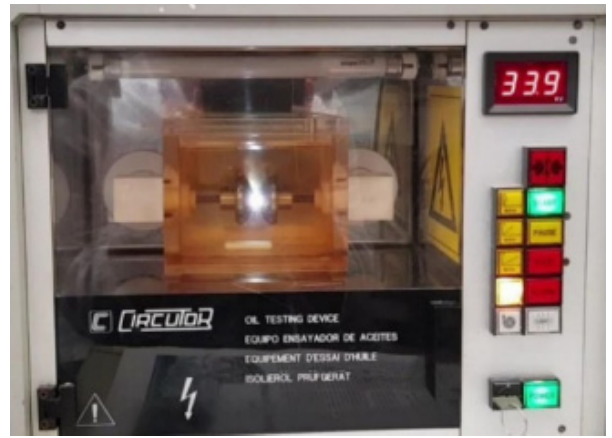
Figure 5. Breakdown voltage tester